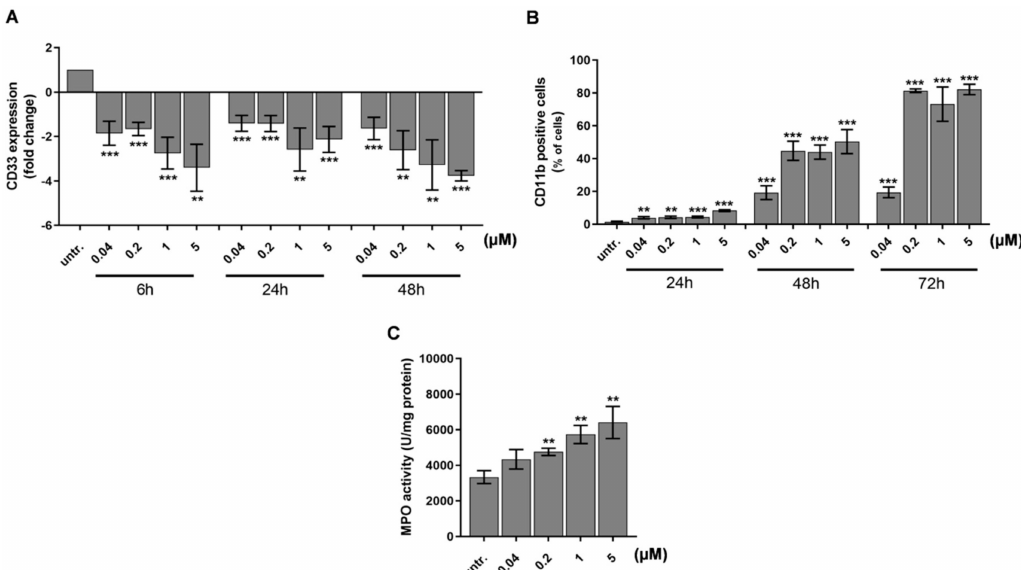
Figure 4. DU325 induces di ff erentiation of HL-60 promyelocytes. As a proof of cellular di ff erentiation, the expression of AML blast and leukemia stem cell marker CD33 decreased ( A ). Matured myeloid cell marker CD11b elevated on the cell surface detected by flow cytometry ( B ). Due to maturation, the myeloperoxidase (MPO) activity of HL-60 cells increased upon treatment after 48 h ( C ). Cells were assayed as described in the Materials and Methods Section 4.12.4. for CD33 and CD11b immunostaining, and 4.11. for the MPO activity. Data are shown as arithmetic mean values ± standard deviation from triplicate experiments. Statistical significance was calculated in relation to untreated cells and set to ** p < 0.01, *** p <